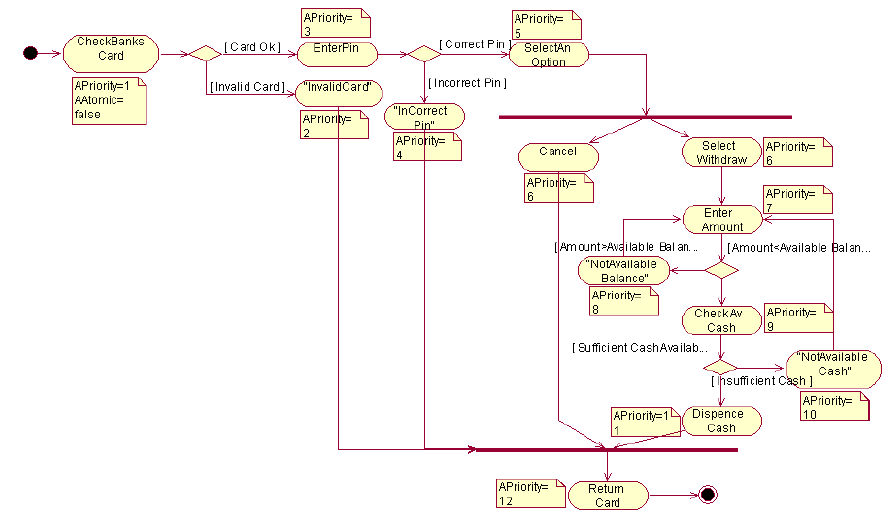
Fig. 11. withdrawal activity diagram annotated with tags